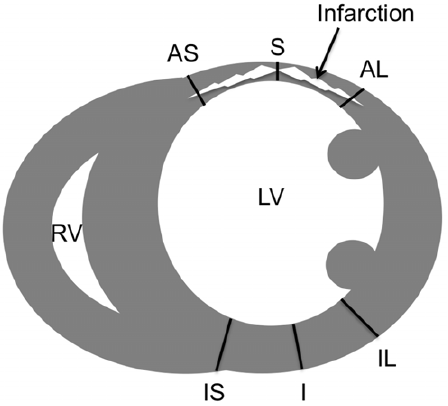
Figure 3. Schematic illustration for determination of hypertro- phy. The illustration shows the six locations of wall thickness measurements in a mid-ventricular histological short axis section with scarring of the anterolateral left-ventricular wall. S: scar; AS: anteroseptal borderzone; AL: anterolateral borderzone. Control regions: IS: infer- oseptal wall; I: inferior wall; IL: inferolateral